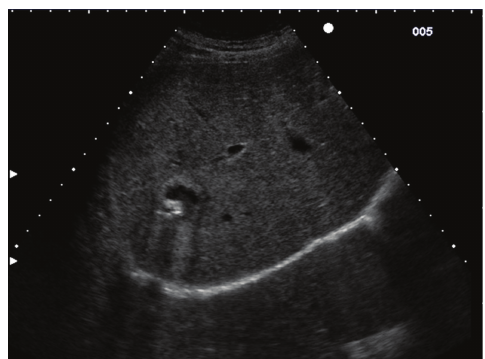
Figure 6: Ultrasound appearance of a brucellar abscess. A central dense calcium deposit is also observed with acoustic